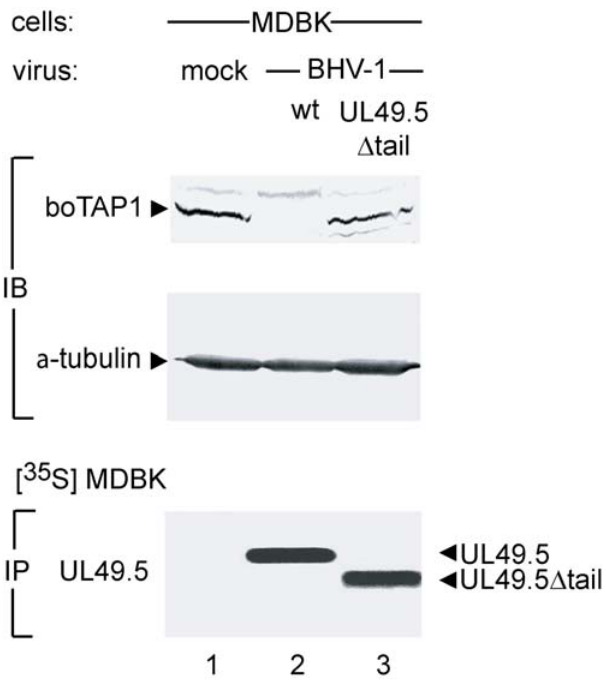
Figure 5. Degradation of bovine TAP is mediated by BHV- 1UL49.5 through its cytoplasmic tail. MDBK cells were mock-infected or infected with wild type BHV-1 or BHV-1 expressing UL49.5 D tail for 12 hours. The levels of bovine TAP1 and, as a control, a -tubulin were assessed in lysates of infected cells by immunoblotting (IB). BHV-1 UL49.5 was immunoprecipitated from lysates of metabolically labeled cells indicates that inhibition of TAP-mediated peptide transport by the interference with peptide binding.